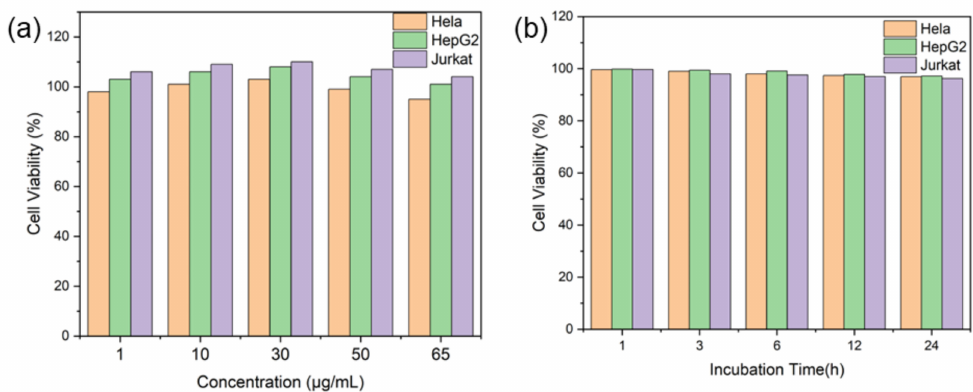
Figure 1. Survival rates of three types of cells co-cultured with SERS boric acid nanoprobes at different ( a ) concentrations (1–65 µ g/mL) and ( b ) times.